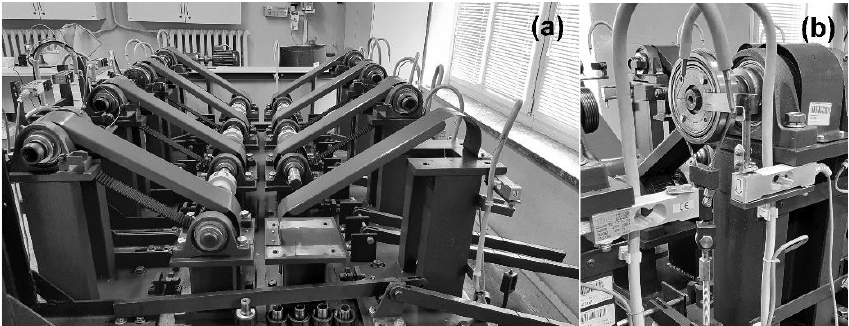
Figure 2. PLS-01 stand ( a ) back view; ( b ) testing shaft, sleeve, and